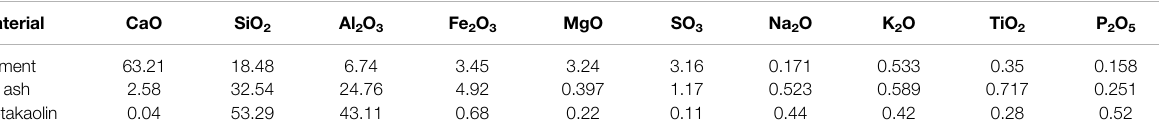
TABLE 4 | Chemical composition of cement, fl y ash, and metakaolin (%). Material Cement